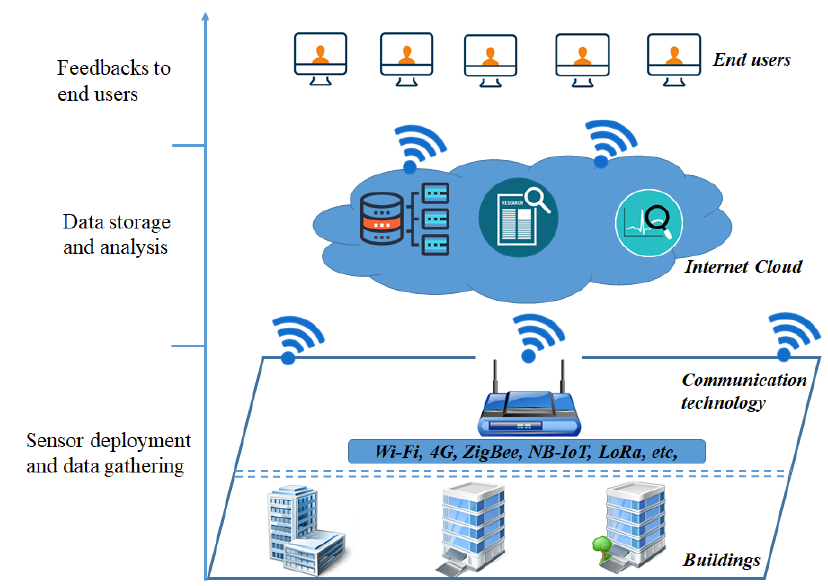
Figure 2. Illustration of the proposed